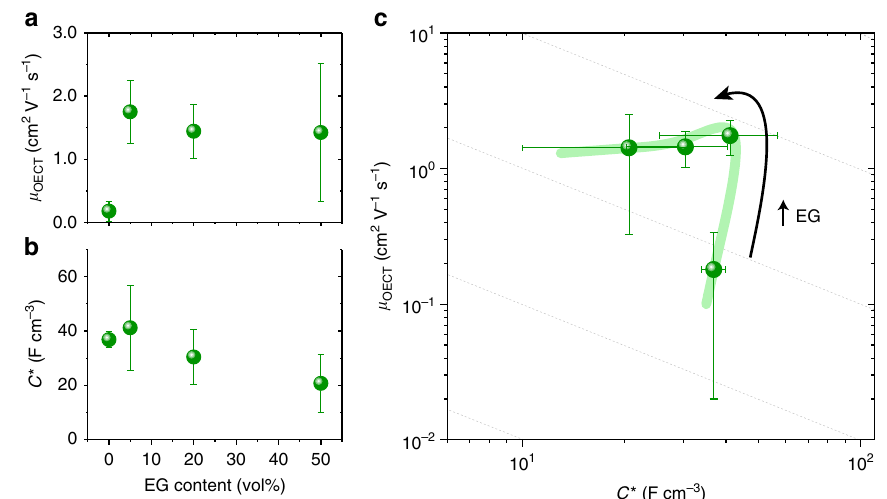
Fig. 4 Formulation/morphology trajectory for PEDOT:PSS. OECT mobility a and C* b as a function of ethylene glycol (EG) concentration. c µ -C* map of data from a , b showing an example of a trajectory corresponding to variations in PEDOT:PSS formulation, and therefore the fi lm morphology/microstructure. Dotted gray lines denote constant µ C* product. Samples are the same as those from ref. 19 . Error bars represent standard deviations from measurements